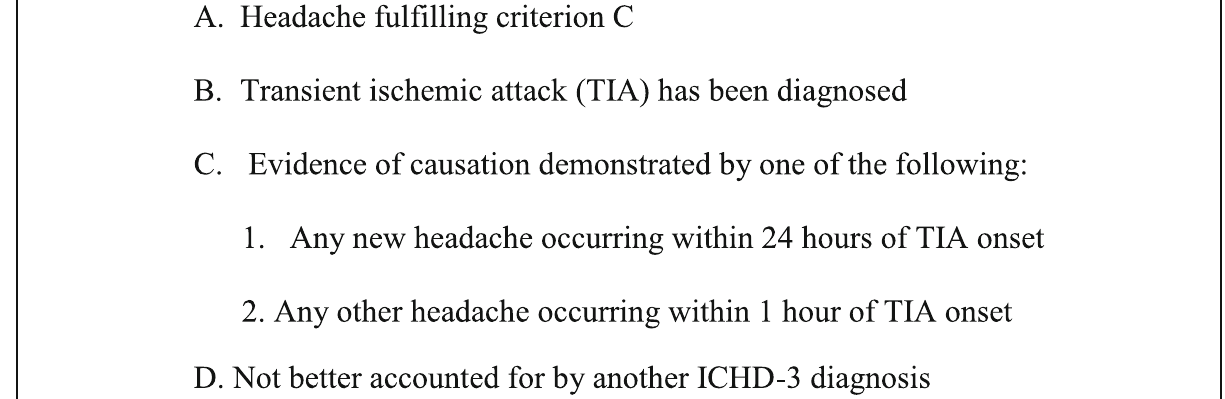
(Fig. 2): C1 “ Any new headache occurring within 24 hours of TIA onset ” and C2 “ Any other headache occur- ring within 1 hour of TIA onset ” . We found that 8 of 120 patients fulfilled the existing criteria and 33 of 120 fulfilled the proposed criteria. That have led to signifi- cantly greater sensitivity ( p < 0.0001). The proposed new diagnostic criteria were fulfilled by 0.5% of our controls and no controls fulfilled the existing criteria ( p = 0.32).